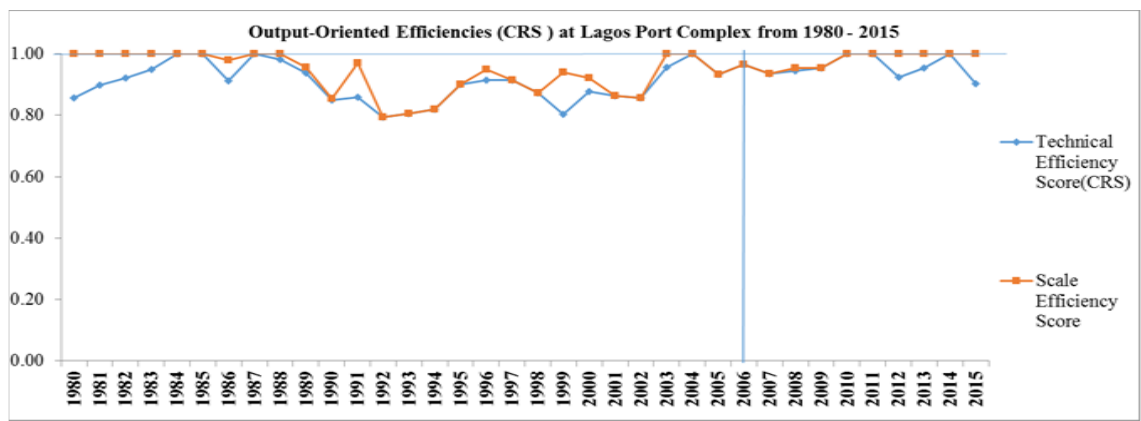
Figure 2: CRS – Technical Efficiency (Output-oriented) and CRS – Scale Efficiency (Output- oriented) at Lagos Port Complex from 1980 – 2015